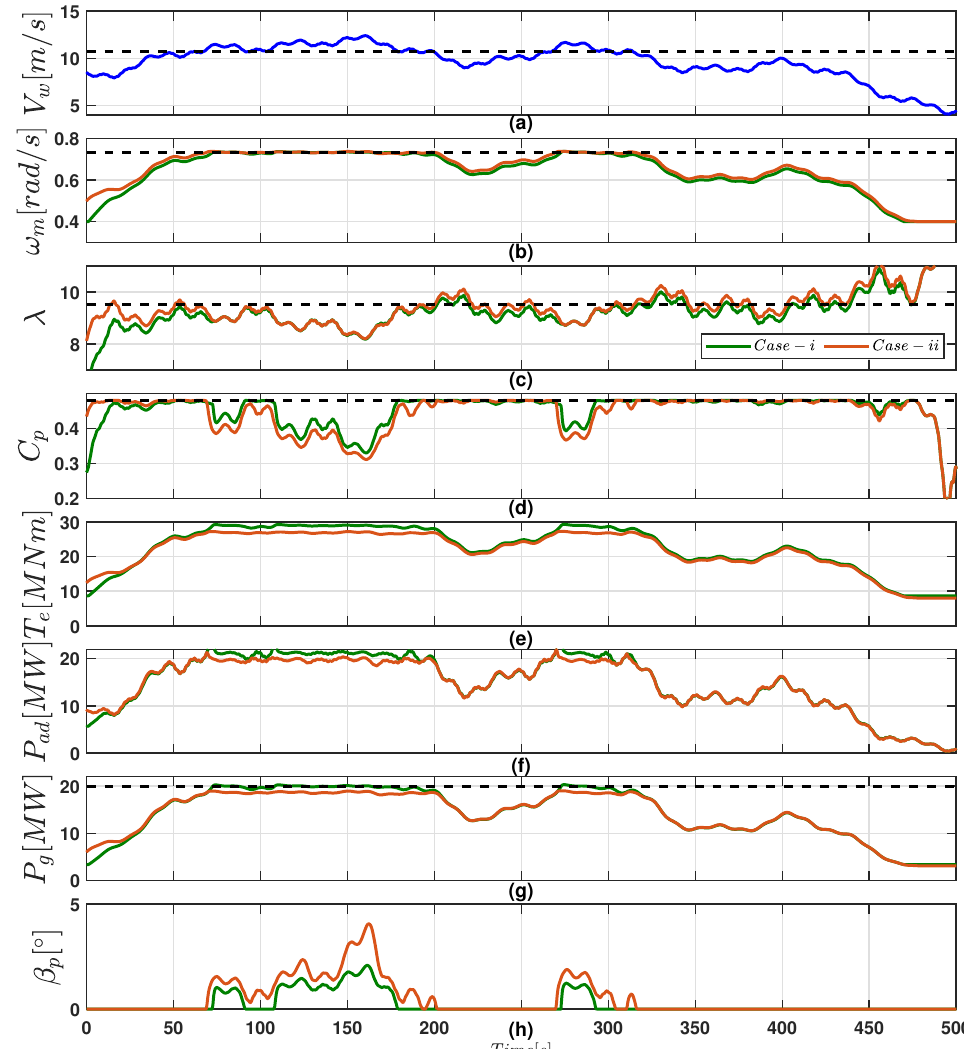
Figure 20. Comparative results to validate the influence of environmental factors in aerodynamic power